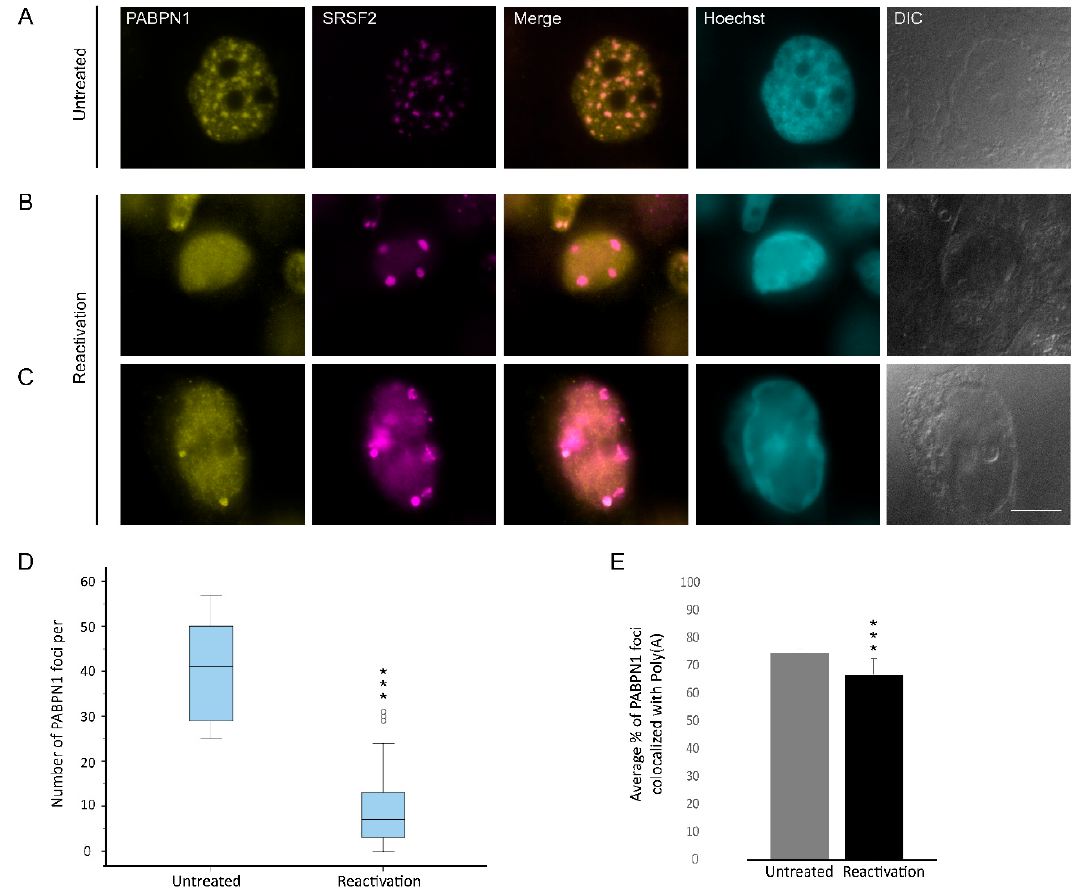
Figure 7. The distribution of PABPN1 during lytic reactivation of KSHV infection. PABPN1 (yellow) in ( A ) untreated cells compared to ( B , C ) BAC16-infected iSLK cells that were treated to induce the lytic cycle of KSHV infection for 48 h and stained with anti-SRSF2 (magenta); Hoechst in cyan; DIC in grey. Bar, 10 µ m. ( D ) Measurements of the average numbers of PABPN1 foci per nucleus. For the box plot: center line, median; box limits, upper and lower quartiles; whiskers, minimum to maximum range. (*** p < 0.001) ( E ) The average percent of the PABPN1 foci that colocalized with the poly(A) foci (nUntreated = 75, nReactivation = 34 cells) (*** p < 0.001).